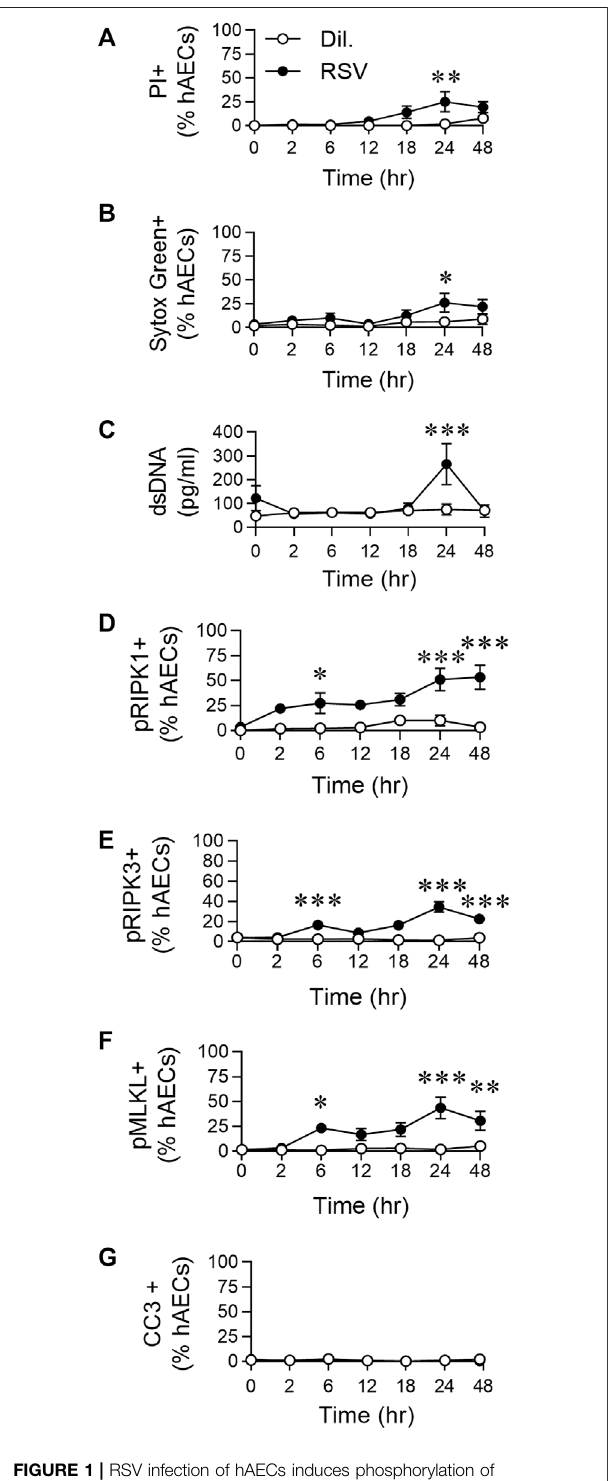
FIGURE 1 | RSV infection of hAECs induces phosphorylation of necroptosis proteins prior to the induction of cell death. hAECs were inoculatedwithRSV(MOIof1)andthecellsanalysedat0,2,6,12,18,24,and 48 h post infection (hpi). (A) Quanti fi cation of propidium iodide (PI) positive hAECs. (B) Quanti fi cation of Sytox Green positive hAECs. (C) dsDNA levels in the cell culture supernatant. (D – G) Quanti fi cation of (D)